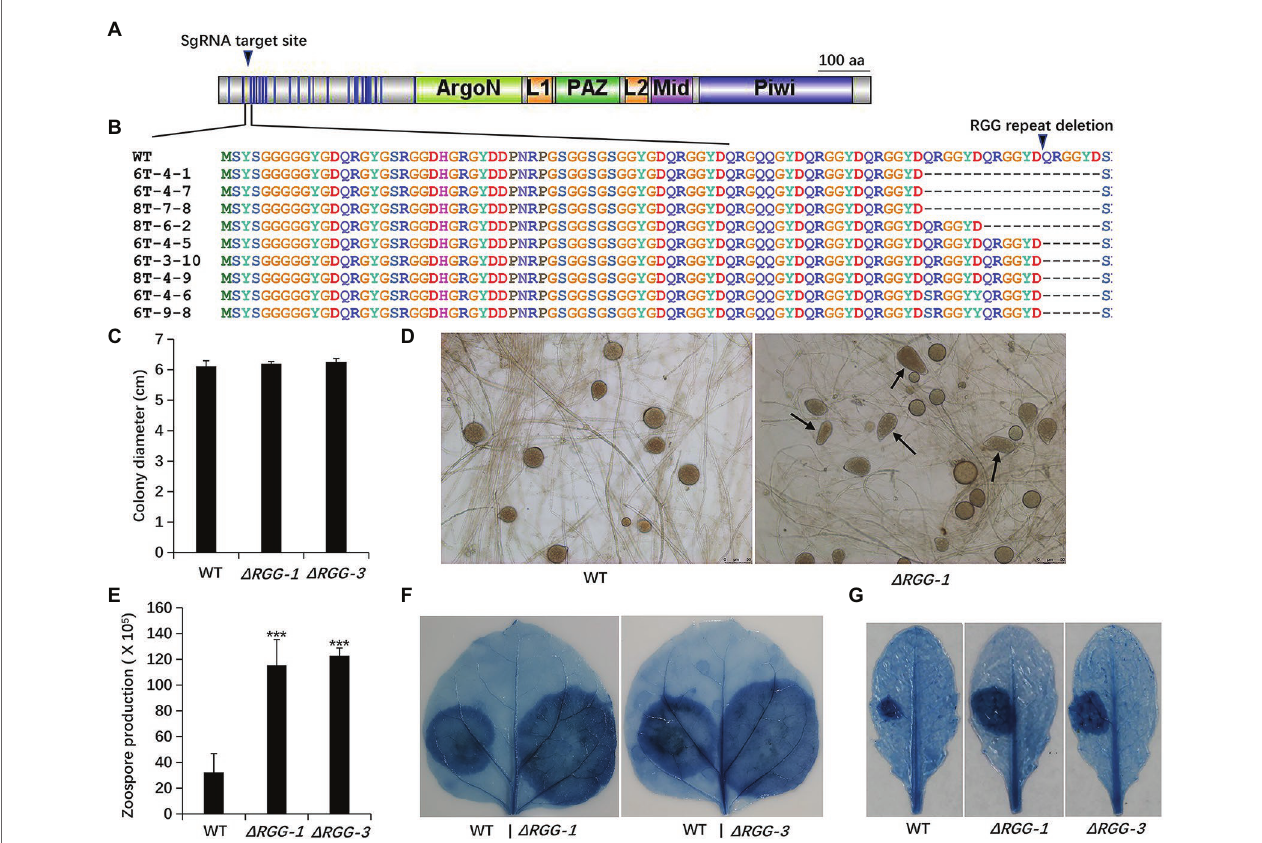
FIGURE 1 | Generation and phenotypic analysis of Phytophthora parasitica mutants PpAGO3 Δ RGG1 and PpAGO3 Δ RGG3 . (A) The designed sgRNA targeting sites on PpAGO3 protein. (B) Mutants PpAGO3 Δ RGG1 and PpAGO3 Δ RGG3 were generated by CRISPR-Cas9 technology. Three types of mutation were obtained: an 18 aa (amino acids) deletion (three QRGGYD repeats) in mutants 6T-4-1, 6T-4-7, and 8T-7-8; a 12 aa deletion (two repeats) for mutant 8T-6-2; and a six aa deletion (one repeat) for mutants 6T-4-5, 6T-3-10, 8T-4-9, 6T-4-6, and 6T-9-8. Besides that, a single amino acid substitution within RGG motif was notable for mutants 6T-4-6 and 6T-9-8. Mutants PpAGO3 Δ RGG1 ( Δ RGG-1 ) and PpAGO3 Δ RGG3 ( Δ RGG-3 ) showed similar growth rate to the wild-type, as shown by t -test (C) , produced abnormal sporangium (D) and more zoospores than the wild-type (Student test: *** p < 0.001) (E) , and caused larger lesions than the wild-type on Nicotiana benthamiana (F) and on Arabidopsis thaliana (G) . The detached 5-week-old N. benthamiana and 4-week-old A. thaliana leaves were inoculated with mycelial discs and the water- soaked lesions were examined by trypan blue staining at 48 hpi. Similar results were obtained from three independent